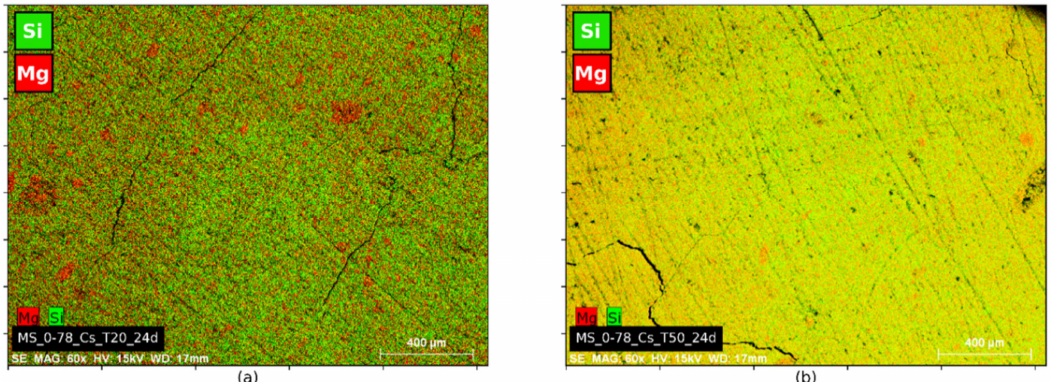
Figure 4. EDS images of M-S-H pastes with M/S = 0.78 and silica fume after 24 days of hydration. ( a ) curing at 20 ◦ C; ( b ) curing at 50 ◦ C.